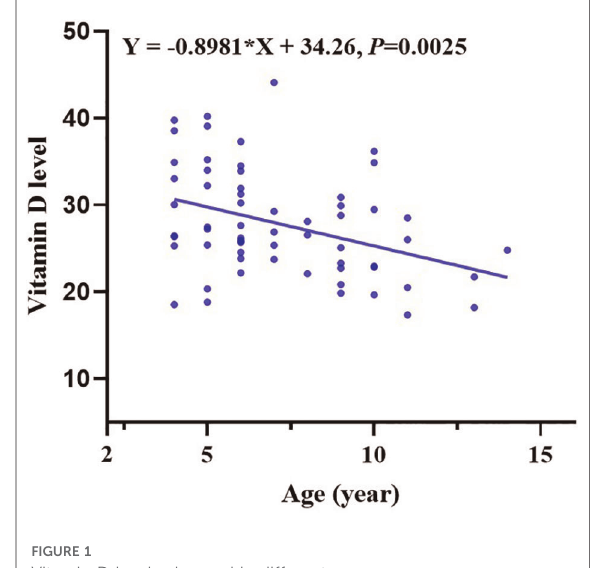
FIGURE 1 Vitamin D levels changed in different ages.